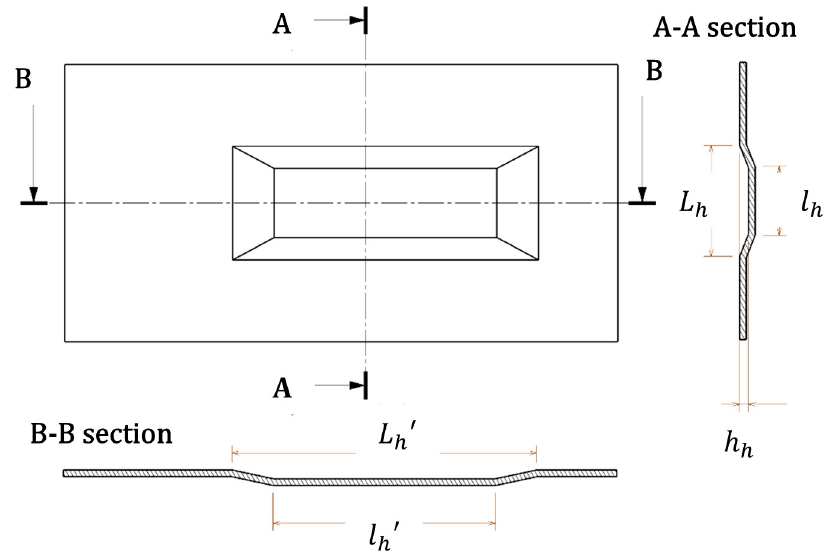
Figure 8. General geometry of the hump for MPSW.